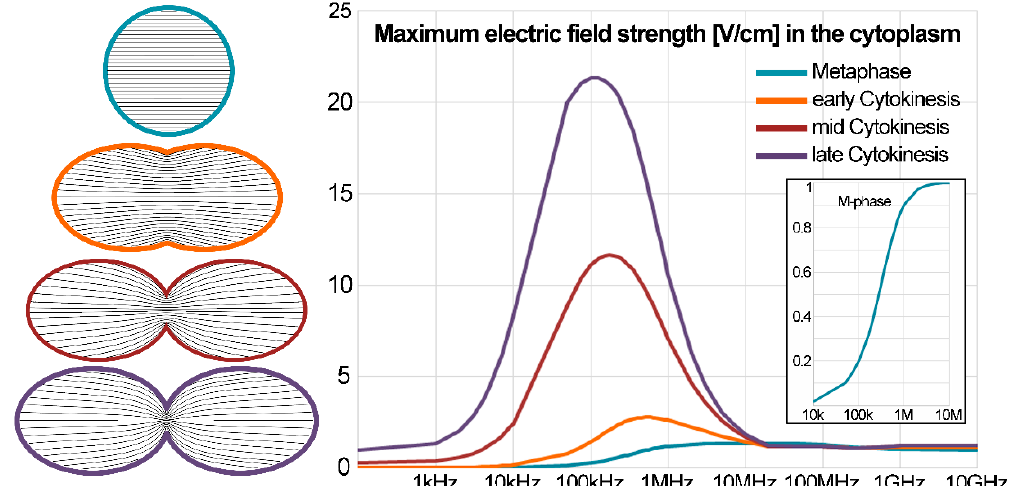
Figure 1. ( Left ) Schematic diagrams of the cell geometries for metaphase and three stages of cytokinesis. Black lines indicate the electric field contours. ( Right ) The maximum intracellular electric field strength in V/cm plotted as a function of field frequency for the four cell shapes subject to an electric field with a 1 V/cm intensity.